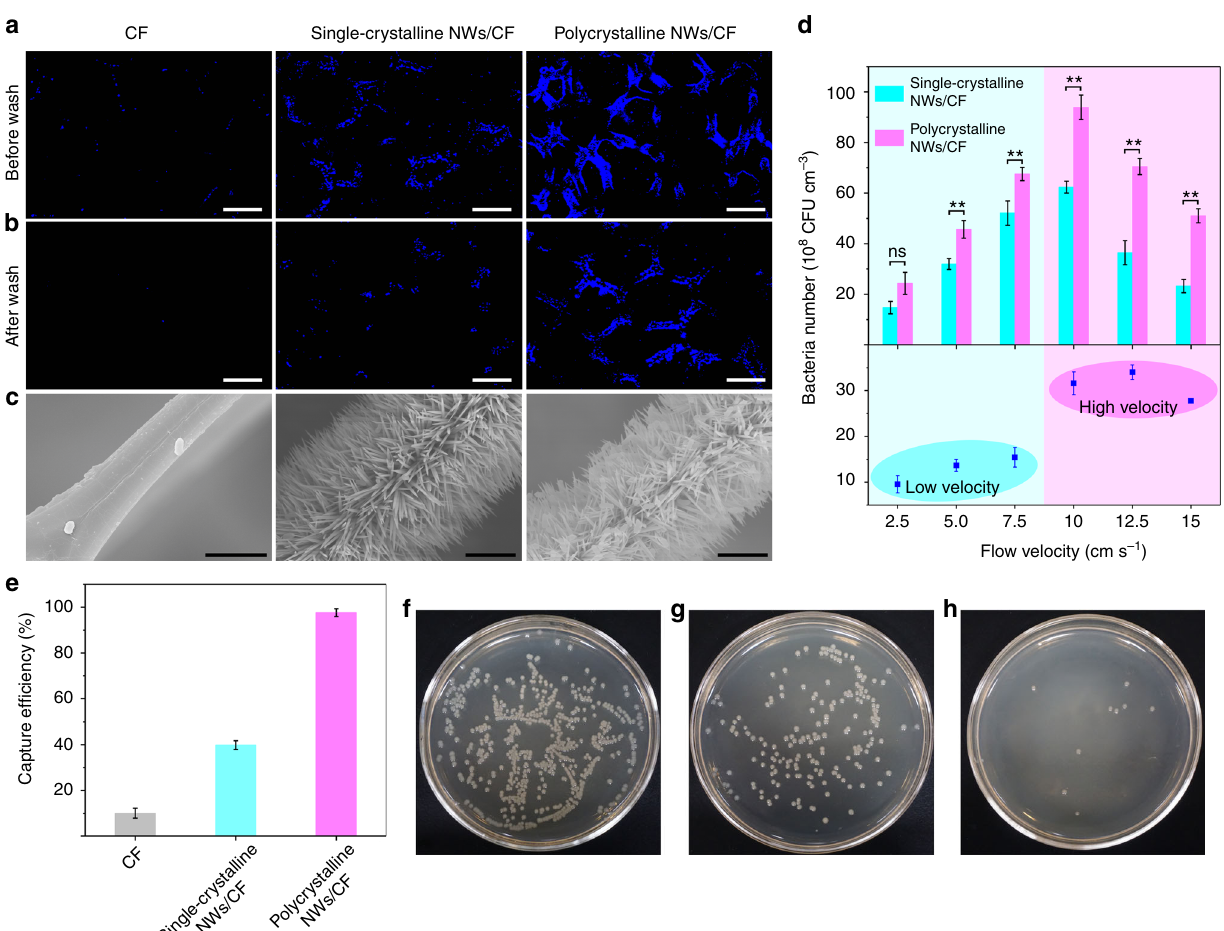
Fig. 5 Bacteria capturing performance in the bloodstream. Fluorescent images of bacteria captured in three dialyzers a before and b after washing with sterile normal saline at a fl ow velocity of 20 cm s − 1 for 2 min. The bacteria were stained with DAPI shown in blue. Scale bars in a and b are 100 μ m. c Corresponding SEM images of the dialyzers after washing. Scale bars, 5 μ m. d Quantitative evaluation of the number of captured bacteria using Con A- modi fi ed dialyzers at different fl ow velocities, and the difference in the number of bacteria captured between the dialyzers. e Bacterial capturing ef fi ciencies of the three dialyzers. Bacteria spiked into adult human blood and fl owed through the dialyzers at 10 cm s − 1 . f – h Photograph of an agar plate visualizing the residual bacteria among three dialyzers, including f CF, g single-crystalline NWs/CF, and h polycrystalline NWs/CF. Error bars: standard error ( n = 3). Student ’ s t -test, ** P < 0.01; ns, not signi fi